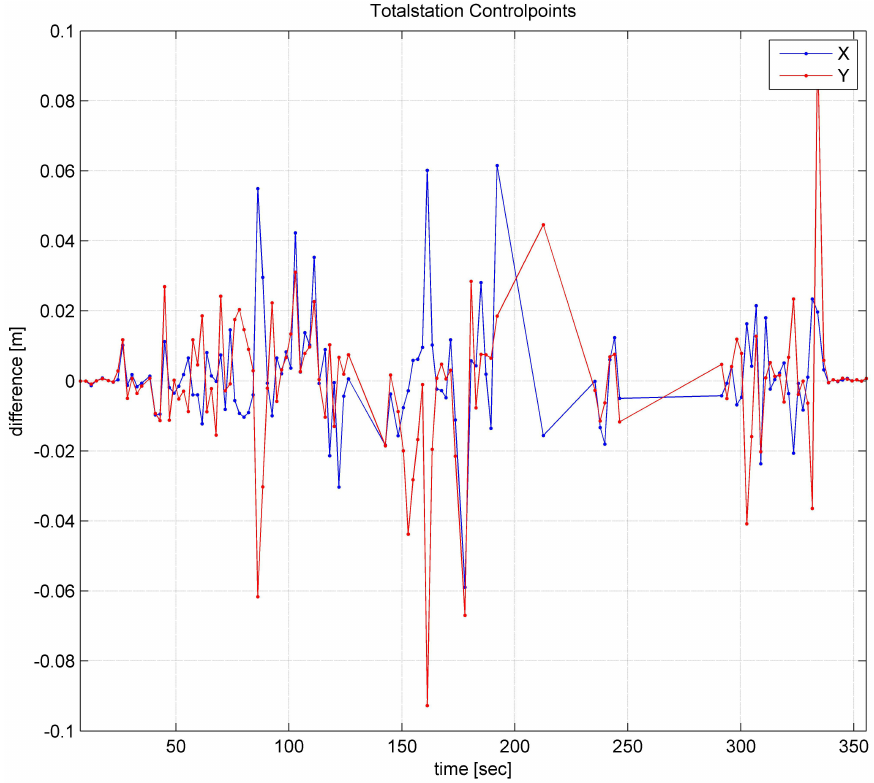
Figure 9. Differences between the control points of the total station without the GEOCOMconnection and the solution from the Kalman filter with trajectory Case